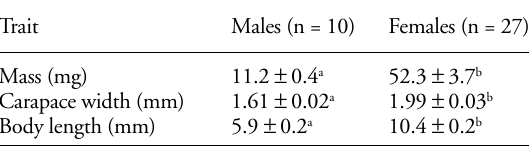
Table 1. Body size traits (mean ± SE) for the individuals of Leucauge venusta . Letters indicate significant differences between the means (p < 0.0001).